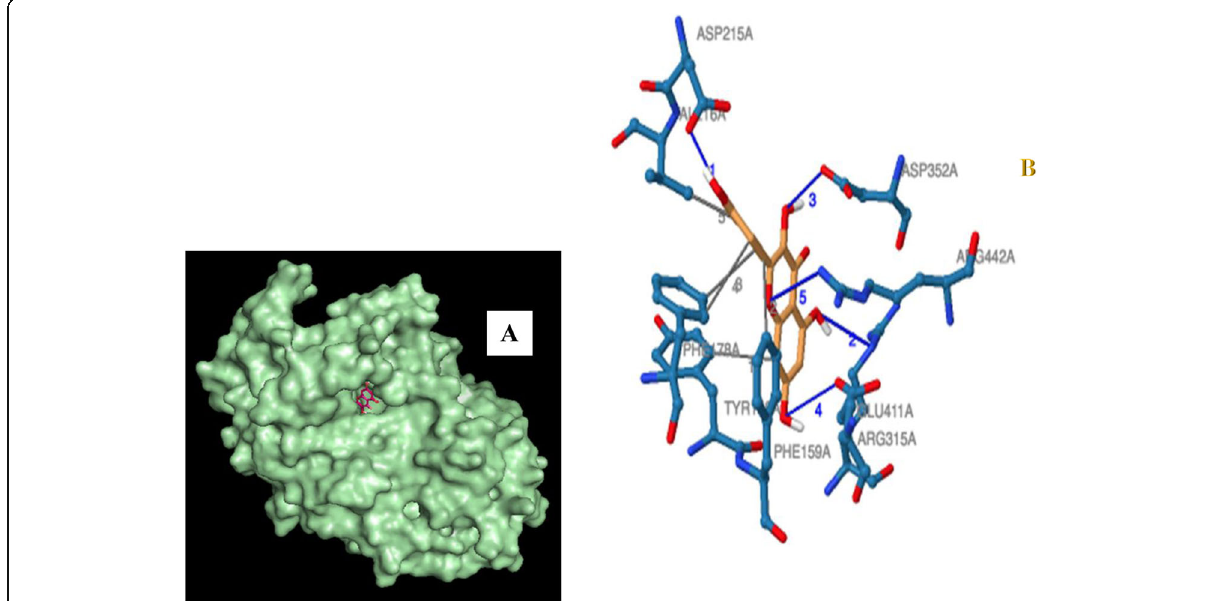
Fig. 4 Binding pose and binding site of kaempferol with α -glucosidase (panel A), molecular interaction of kaempferol with amino acid residues within the binding pocket of the protein structure (panel